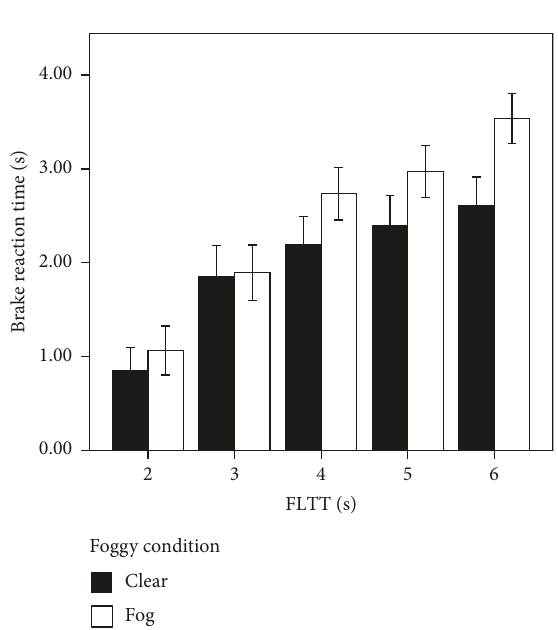
Figure 12: Mean BRT for the interaction between flashing light trigger timings and foggy